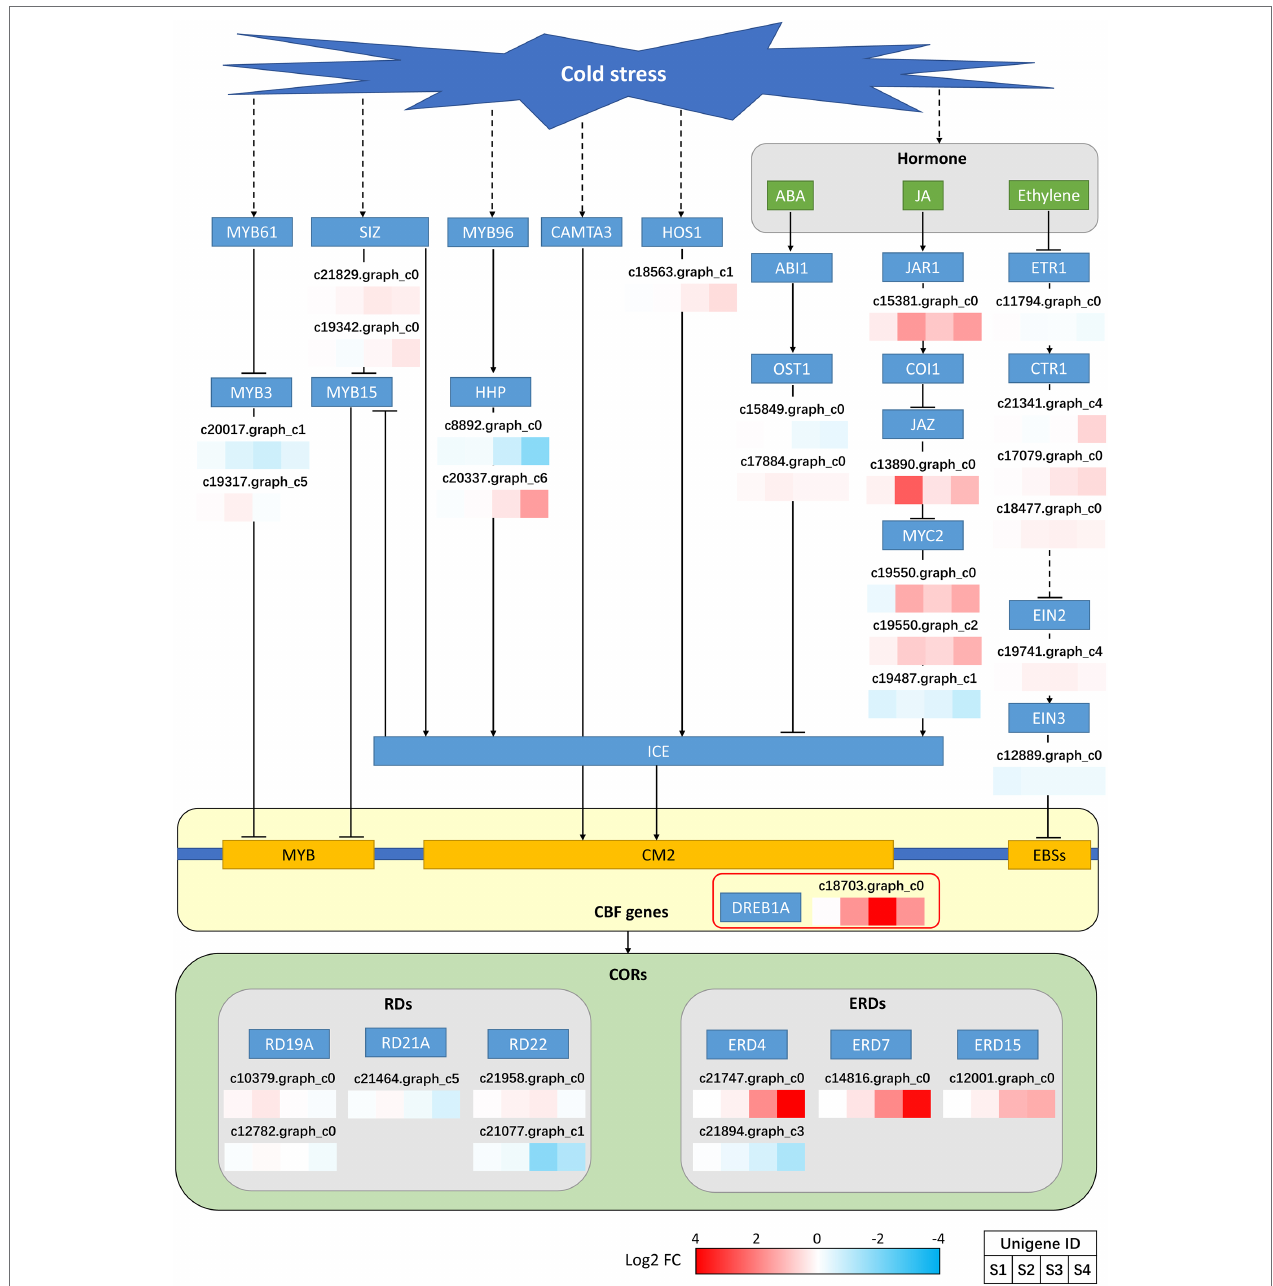
FIGURE 3 | Expression of CBF-mediated upstream and downstream genes in P. auriculata after different cold stress treatment times